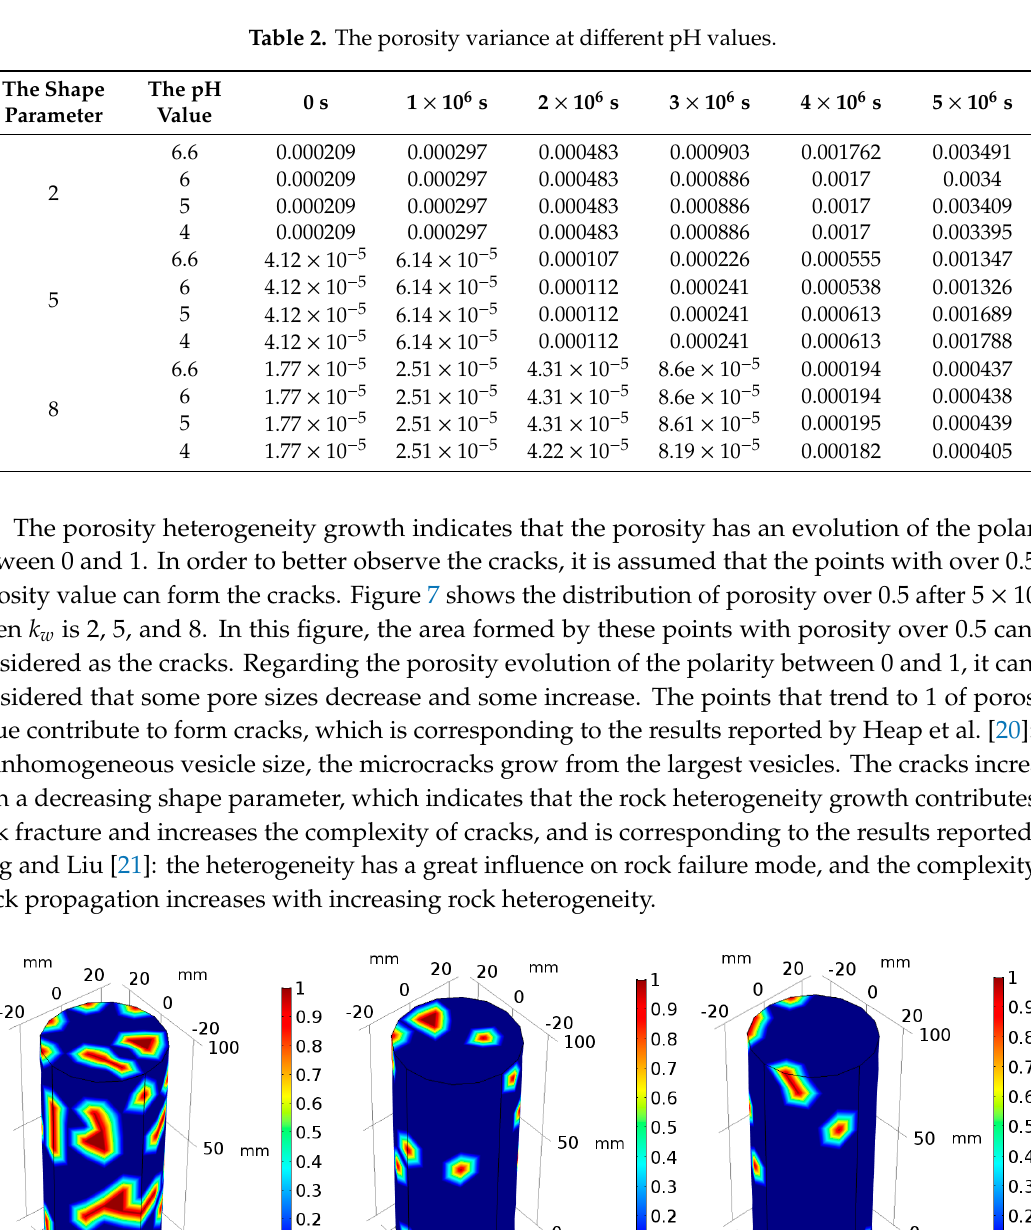
k = 5; ( c ) k = 8. Figure 7. The distribution of porosity over 0.5 after 5 × 10 6 s (pH = 4): ( a ) = 2; ( b ) k = 5; ( c ) k = w w w w